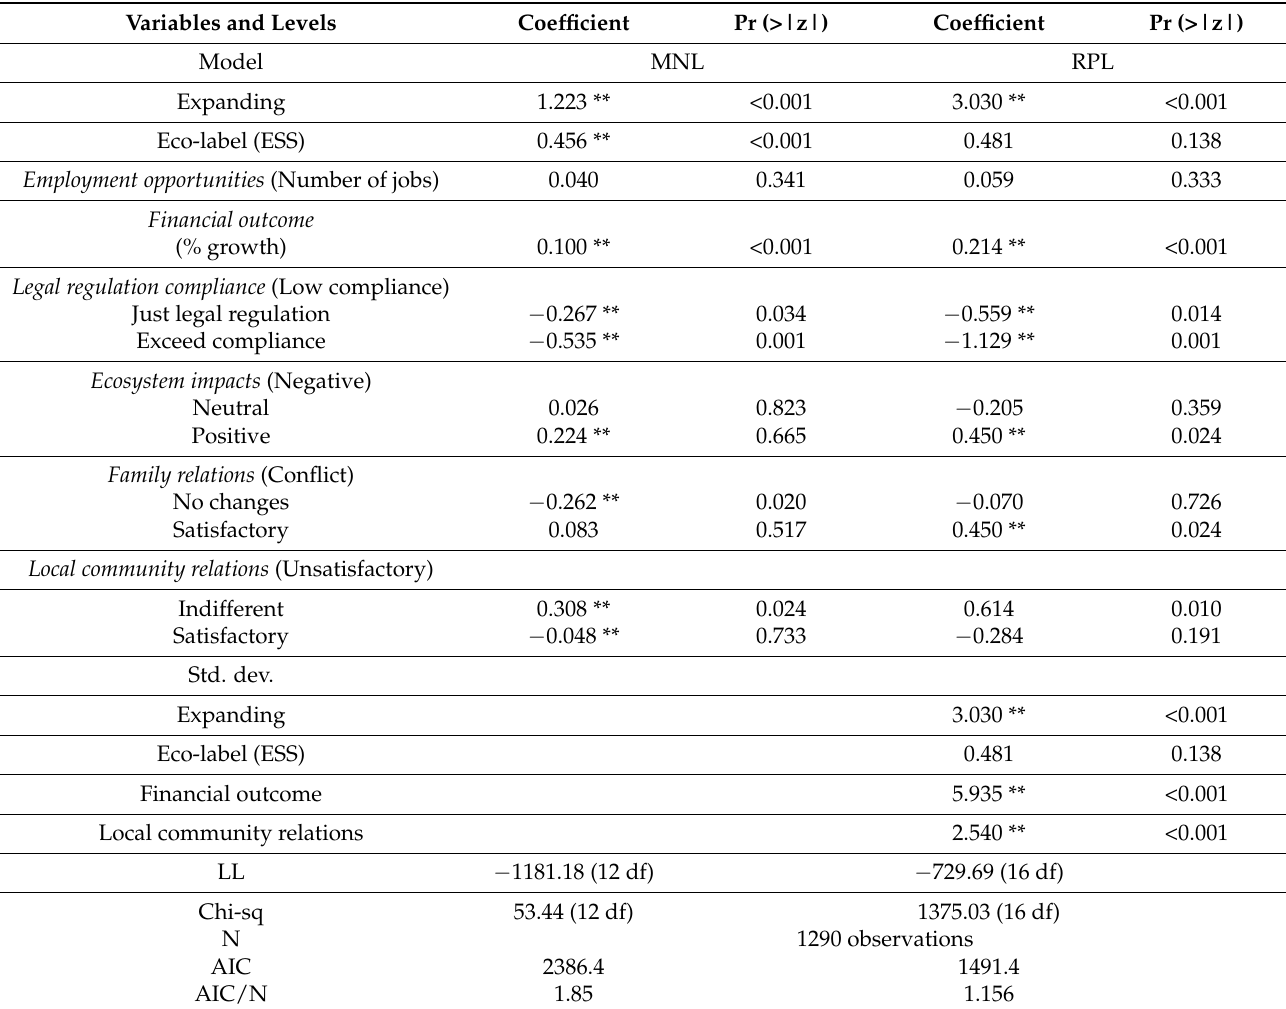
Table 3. Models for the full sample.